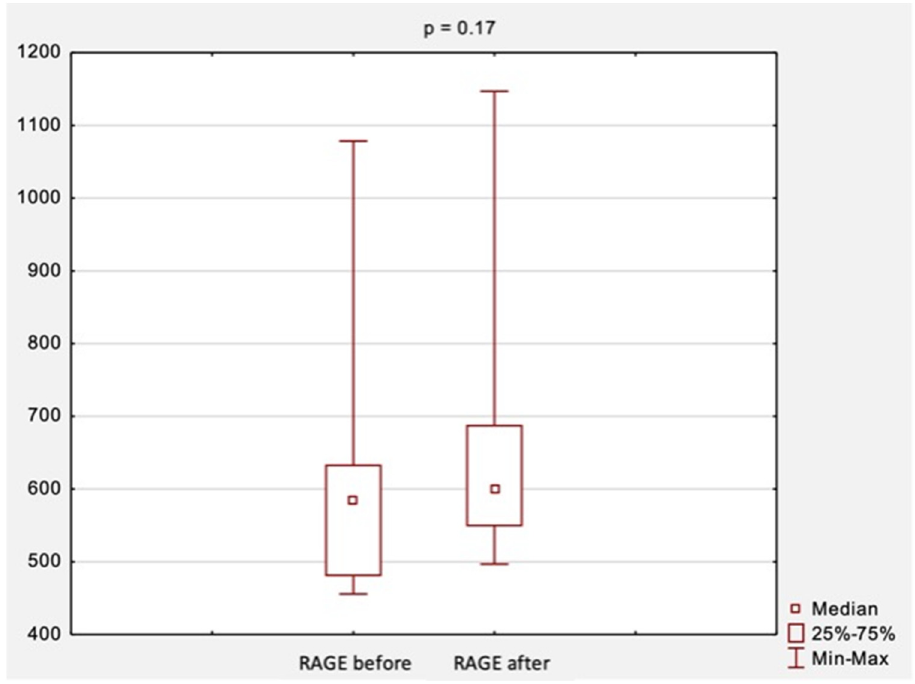
Figure 3. The comparison of RAGE levels before and after surgical treatment. Abbreviations: RAGE, receptor for advanced glycation end products; p, level of statistical significance.